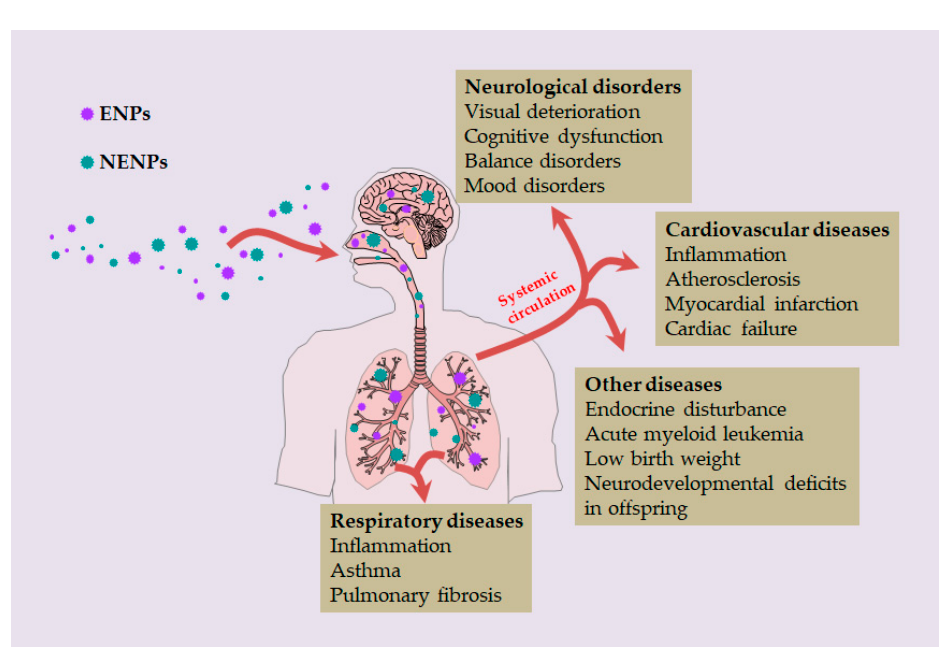
Figure 5. Human health hazards caused by inhaled NPs.